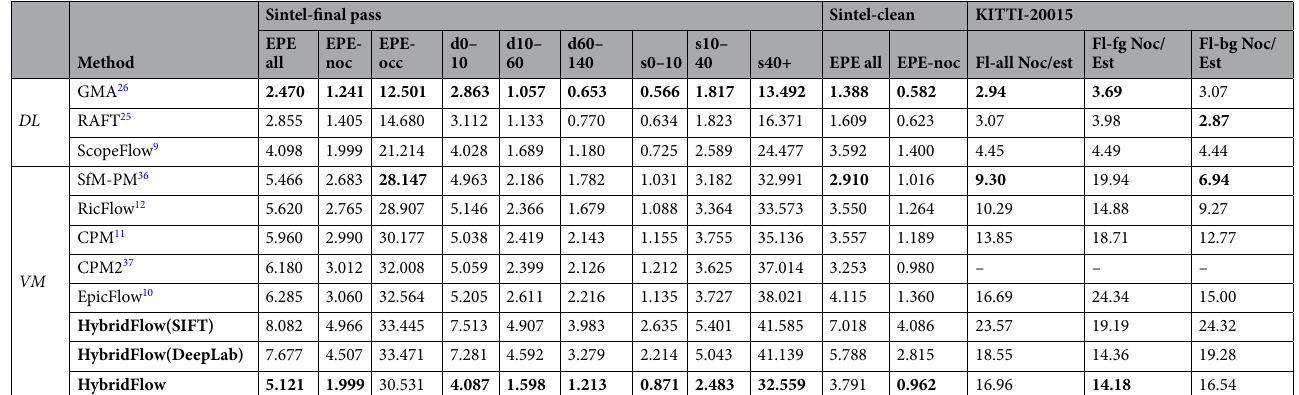
Table 1. Benchmark datasets results. The top half of the table ( DL ) are the top-performing deep learning methods; the bottom half of the table ( VM ) are the top-performing variational methods. For MPI-Sintel results, EPE-noc is the EPE on the non-occluded areas, and EPE-occ is the EPE on occluded areas. s0–10 is the EPE for pixels whose motion speed is between 0 and 10 pixels, similarly for s10–40 and s40+; d0–10 is the endpoint error over regions between 0 and 10 pixels apart from the nearest occlusion boundary, similarly for d10–60 and d60–140. For the KITTI-2015 test-set non-occluded pixels, FI-bg is the percentage of optical flow outliers for background, FI-fg is the percentage of optical flow outliers for the foreground, FI-all/Est is the percentage of outliers averaged over all non-occluded ground truth pixels. Best performance shown in